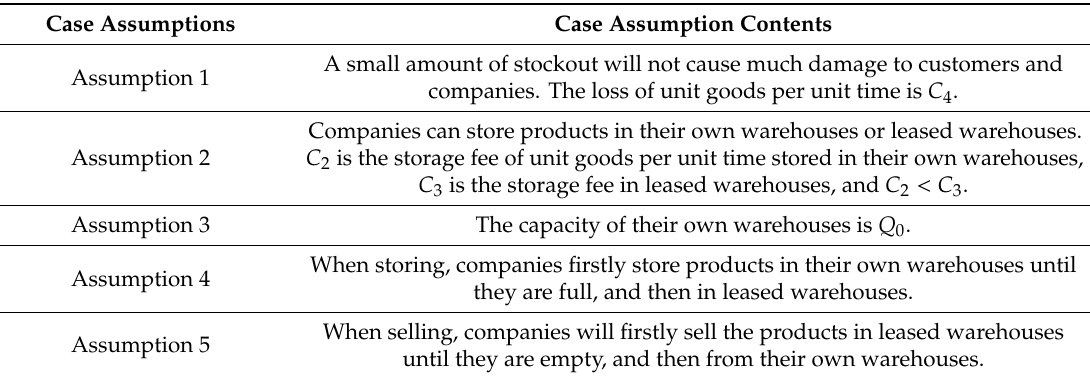
Table 4. Case assumptions of the inventory